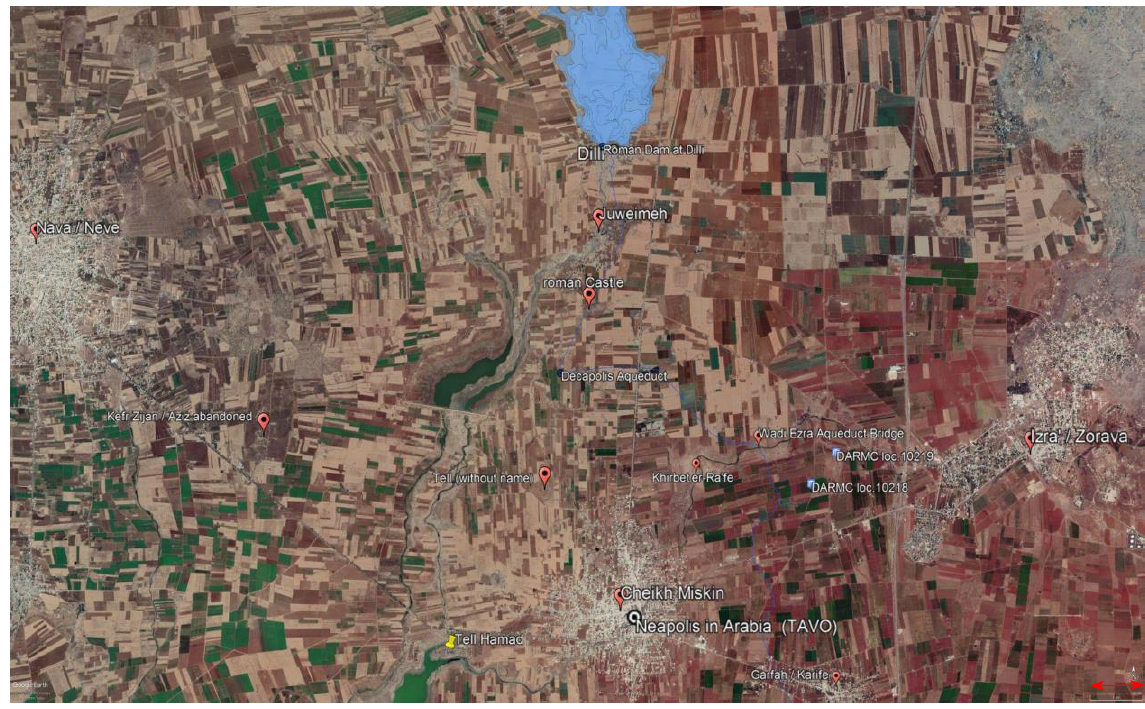
Figure 4: Overview of the different locations mentioned Scale and Direction embedded (GoogleEarth / DigitalGlobe